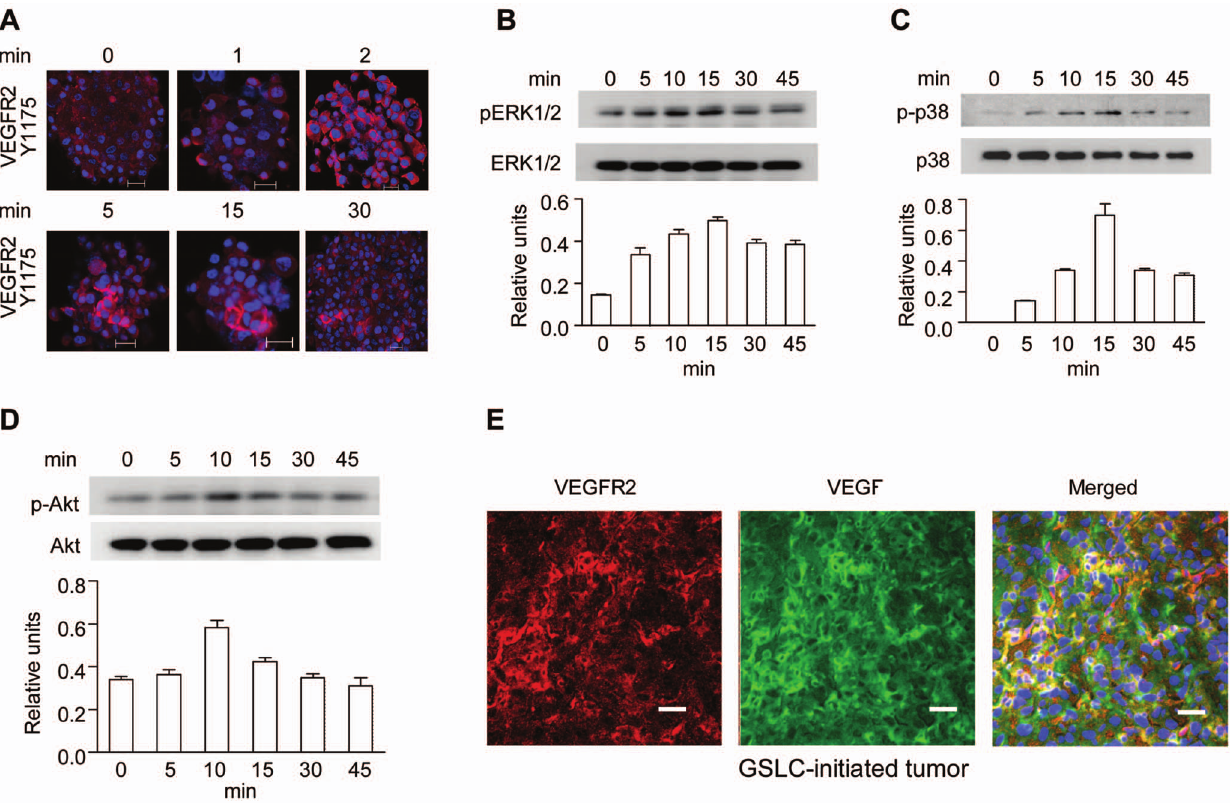
Figure 4. VEGF-induced phosphorylation of VEGFR-2, ERK, p38 and PI3K in GSLCs. ( A ) IF images of phosphorylation on Y1175 in VEGFR-2 in GSLCs stimulated by VEGF (10 ng/ml) for different minutes (min). Scale bar=20 m m. ( B–D ) Western blot of ERK, p38 and AKT phosphorylation in GSLCs treated with VEGF (10 ng/ml) for different times (min). ( E ) IF double-staining of VEGFR-2 and VEGF in GSLC-initiated xenograft tumors. Scale bar=20 m m. VEGFR-2 (red), VEGF (green).